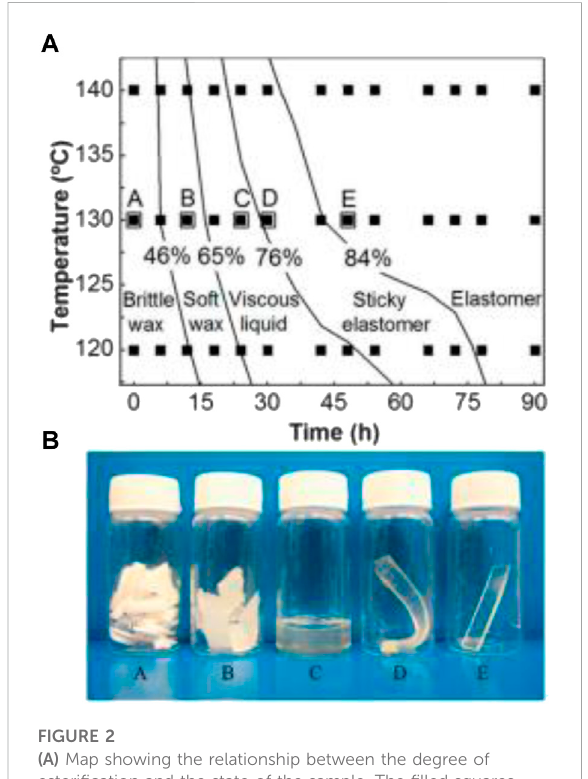
FIGURE 2 (A) Map showing the relationship between the degree of esteri fi cation and the state of the sample. The fi lled squares represent the time and temperature values for thermal treatment where the measurement of the degree of esteri fi cation and thephysicalstateofeachsamplewasexamined. (B) Picturesof fi ve samples at ambient temperature: A, brittle opaque wax; B, soft translucent wax; C, viscous translucent liquid; D, soft sticky elastomers; E, non-sticky elastomers. The fi ve large squares with letters on top in (A) represent thethermal treatment conditions for the samples shown in (B) . Reproduced from Li et al.